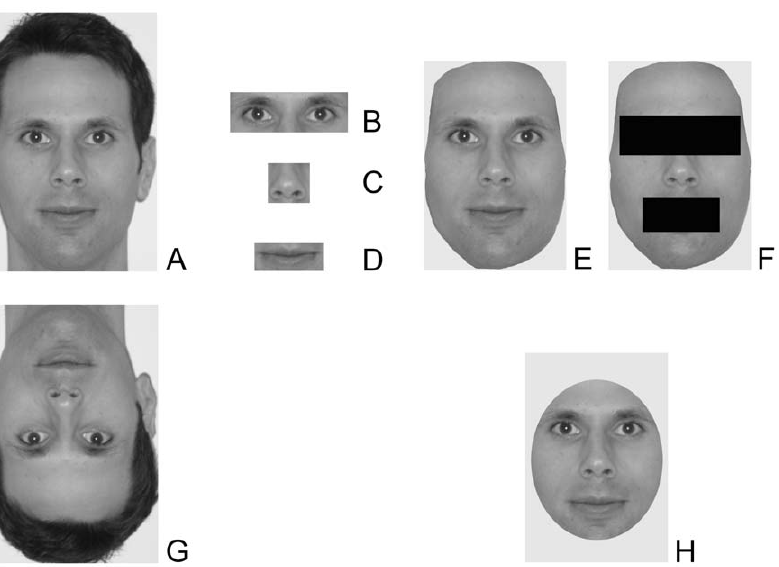
Figure 1. Sample stimuli prepared in the same manner as those used in each of the conditions across Studies 1–4. (a) unaltered but standardized photo from Studies 1, 3, and 4; (b) eyes/brows only condition from Study 2; (c) nose only condition from Study 2; (d) mouth only condition from Study 2; (e) hairless face condition from Study 2; (f) hairless face with eyes and mouth occluded from Study 2; (g) inverted face condition from Study 2; (h) outer shape removed condition from Study 2.